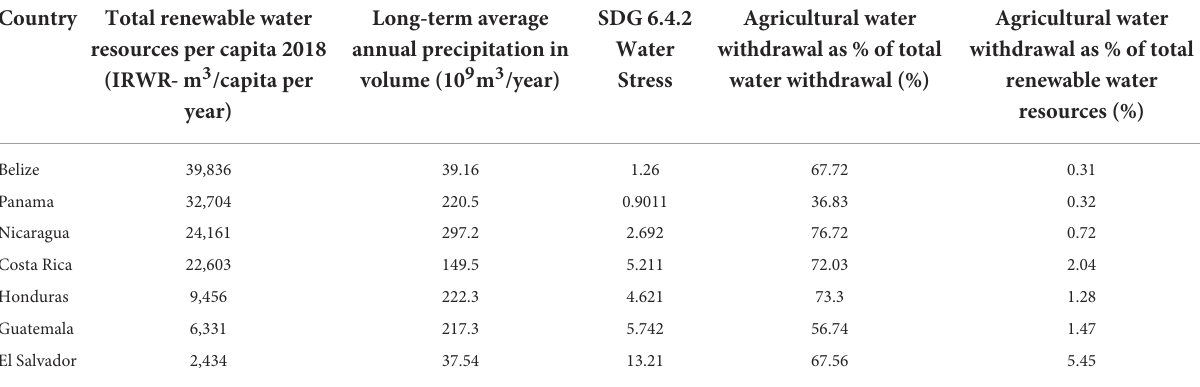
TABLE 3 Average total renewable water resource per capita, long term annual precipitation, water stress and agricultural water withdrawal in 7 Central American countries [Food Agriculture Organization of the United Nations (FAO-AQUASTAT), 2022]. Country Total renewable